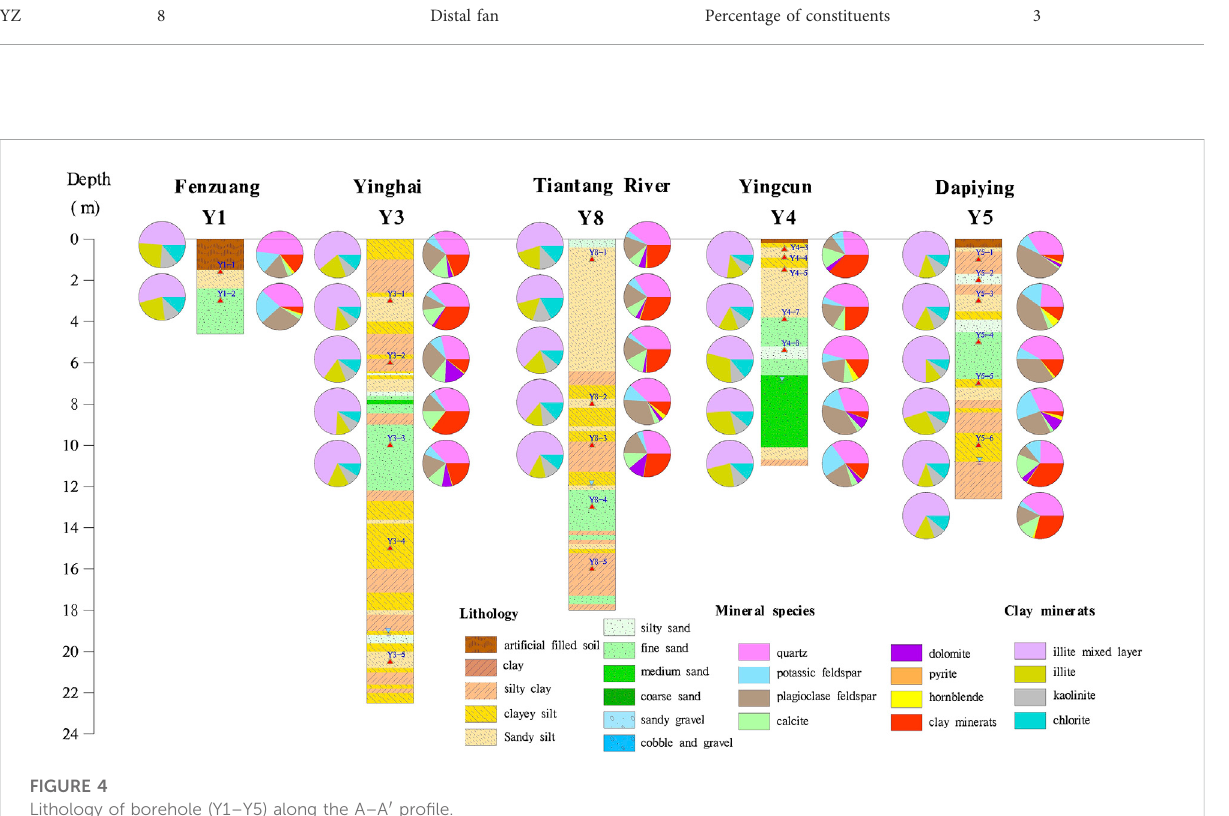
FIGURE 4 Lithology of borehole (Y1 – Y5) along the A – A ′ pro fi le.